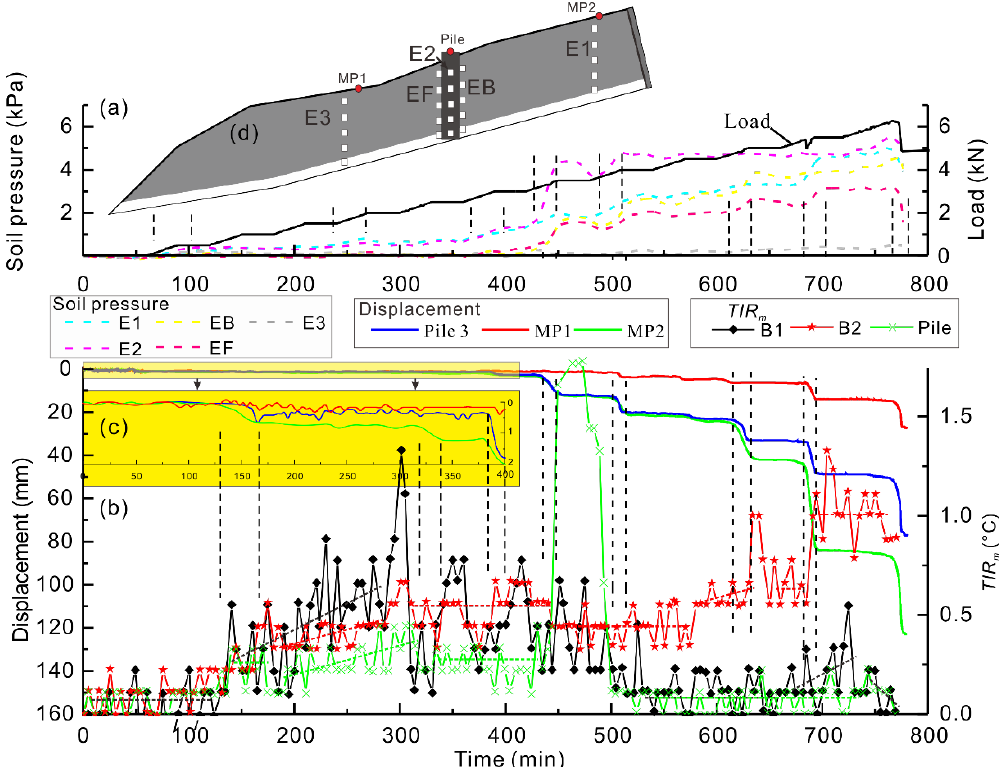
Figure 6. Time-series of load (black line), soil pressures (dashed line) ( a ), displacement (solid line), and 𝑇𝐼𝑅 𝑚 (solid line with symbol) ( b , c ) is the displacement of the model during 0–400 min, showing detailed deformation characteristics. The vertical black dashed lines identify rapid change in displacement and soil pressure curves.